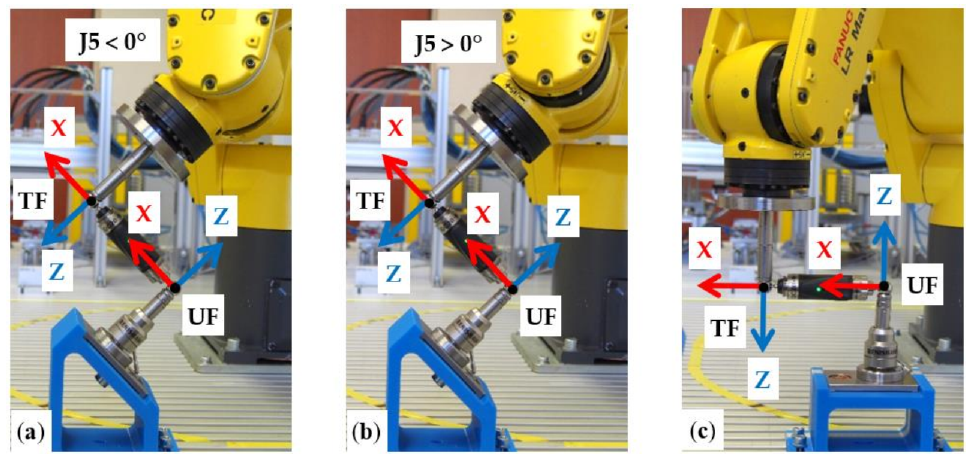
Figure 7. Jigs for measuring in two selected measuring plane. ( a ) NOFLIP configuration; ( b ) FLIP configuration; ( c ) NOFLIP